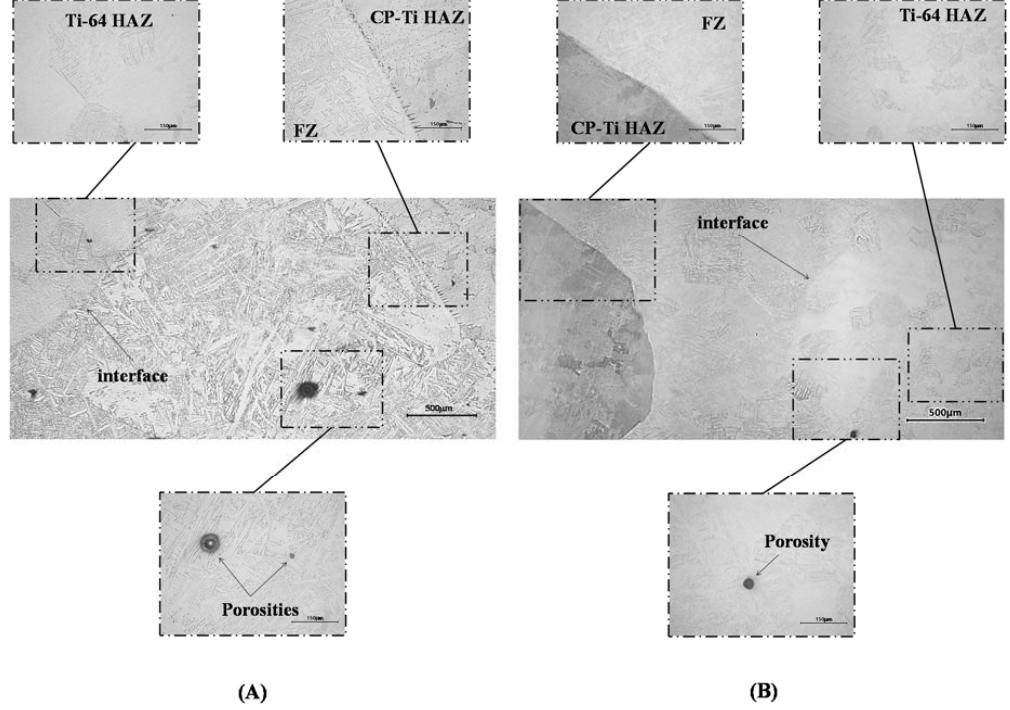
Figure 5. FZ of dissimilar joint for CP ‐ Ti/Ti ‐ 64 welded by ( A ) 3 kW and ( B ) 4 kW laser power.